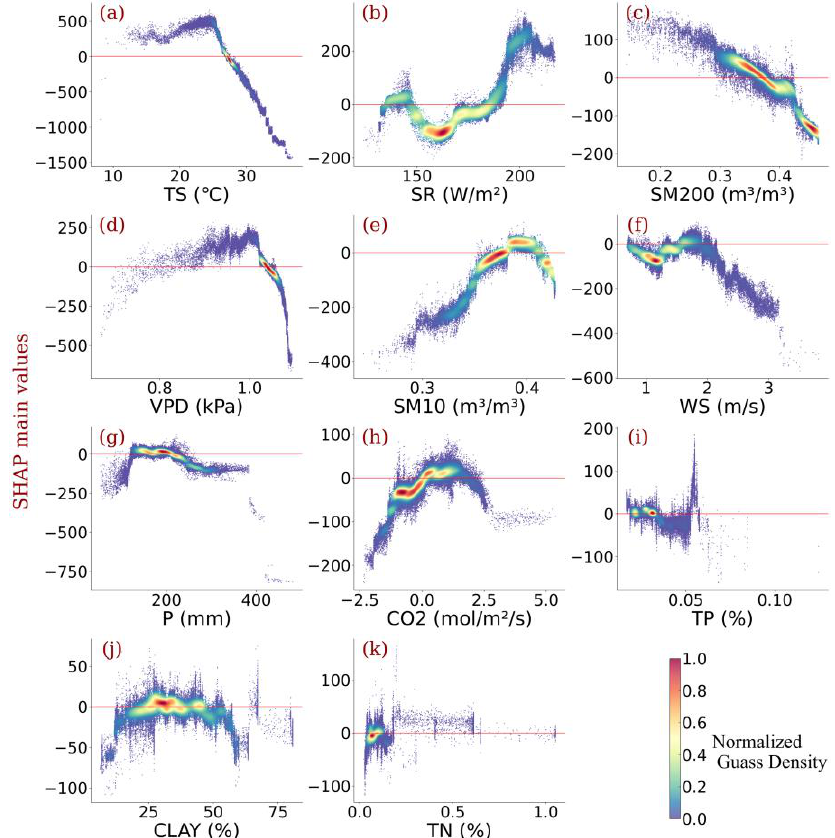
Figure 7. SHAP dependence plots depicting the SHAP main values along the gradient of ( a ) TS, ( b ) SR, ( c ) SM200, ( d ) VPD, ( e ) SM10, ( f ) WS, ( g ) P, ( h ) CO 2 , ( i ) TP, ( j ) CLAY, and ( k ) TN. The lateral axis indicates the gradient of variable values. The vertical axis indicates the magnitude of the SHAP main value. Positive SHAP values indicate the positive force on NPP output while negative SHAP values indicate the opposite. The colors indicate the density. SHAP main values units: g C/m².